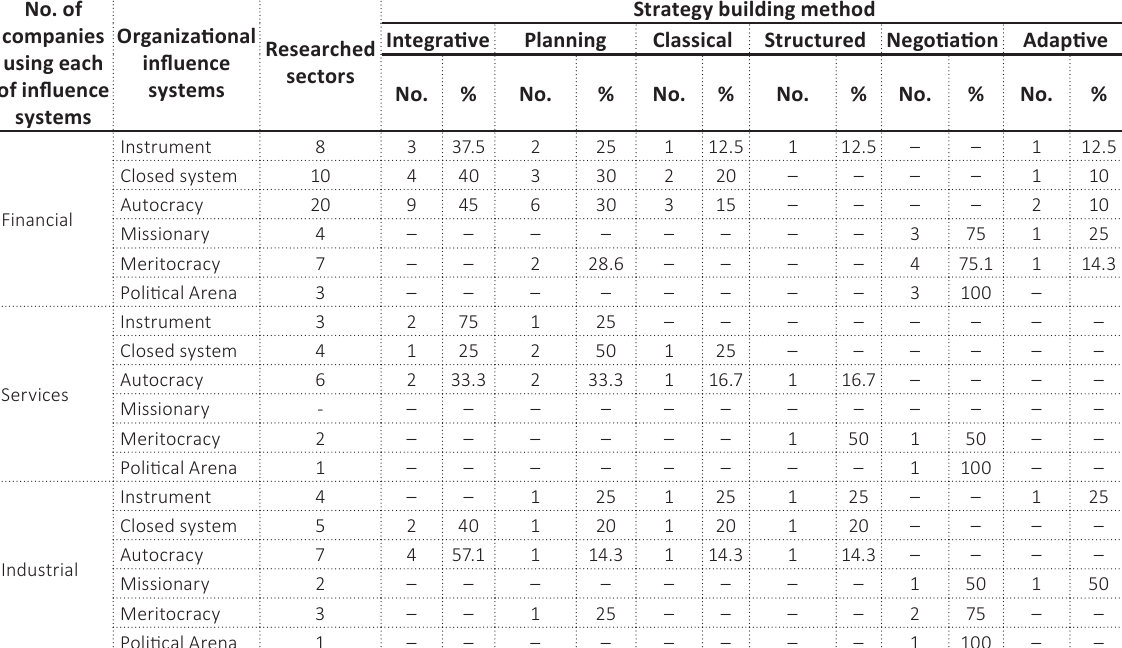
Table 7. Influence systems and strategy building methods in the sample No. of companies using each of influence